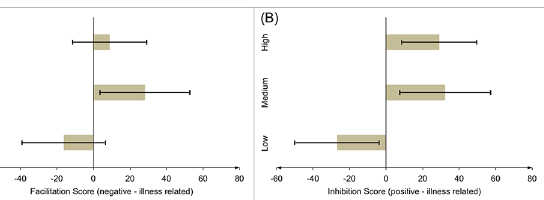
Fig 2. Effects of alexithymia on automatic processing of illness-related information. (A) Estimated marginal means (ANCOVA) of alexithymia groups (high vs. medium vs. low) of facilitation scores under the priming-condition “ negative verbal prime – illness related target ” , controlling for positive and negative affect and depressive symptoms. (B) Estimated marginal means (ANCOVA) of alexithymia groups (high vs. medium vs. low) of inhibition scores under the priming-condition “ positive verbal prime – illness related target ” , controlling for positive and negative affect and depressive symptoms. Note . With regard to Fig 2(A), it has to be noted that error bars of marginal means overlapped between groups. This does not contradict the results of the statistical tests regarding group mean differences. Whereas error bars in Figs 2(A) and (B) are based on individual within-group estimates of variation, the pairwise statistical tests are based on a more reliable overall estimate of within-group variation, simultaneously using data from all three groups.